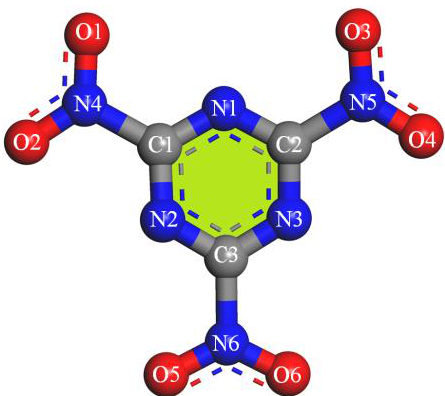
Figure 1. Structure and atomic numbering of